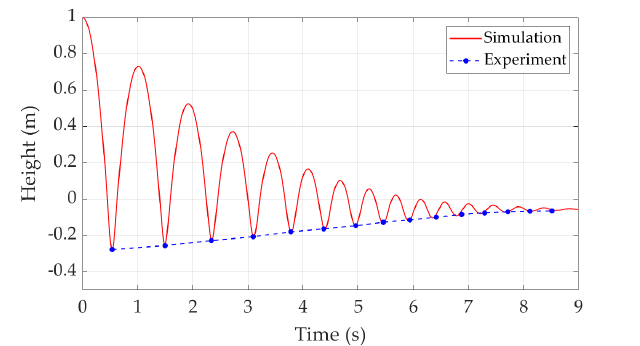
Figure 4. Trampoline dynamic